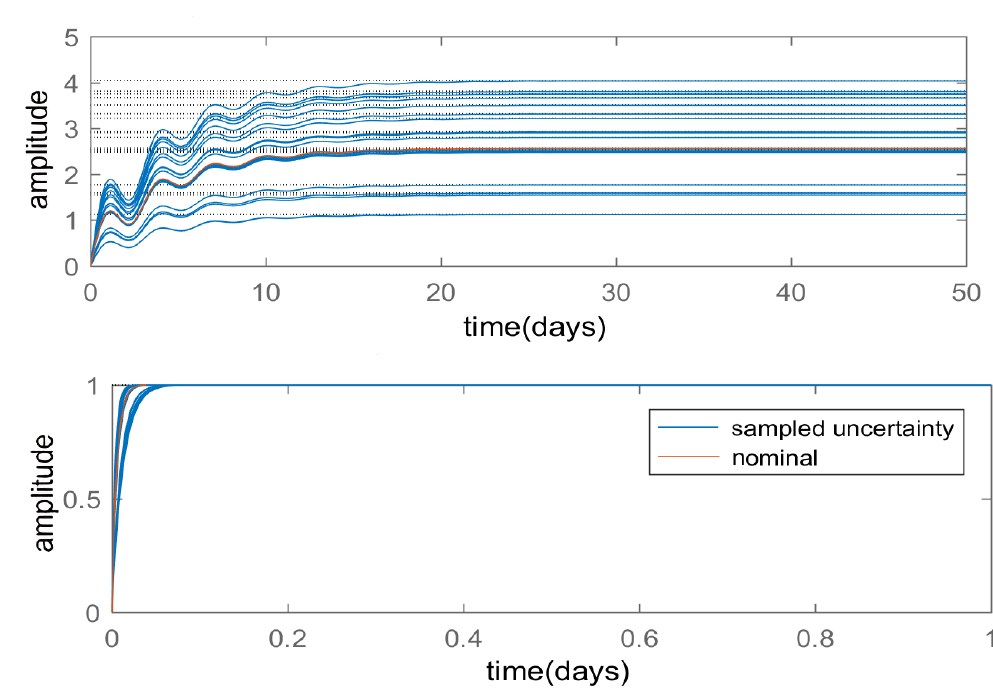
Figure 14. Plots of the plant’s open loop response for parameters uncertainty (first panel) and step input tracking of the fixed structure H ∞ controller in presence of parameters